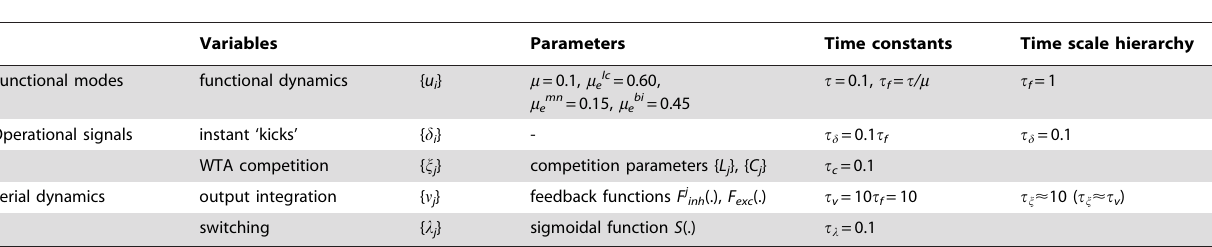
Table 1. Variables, parameters and time scale